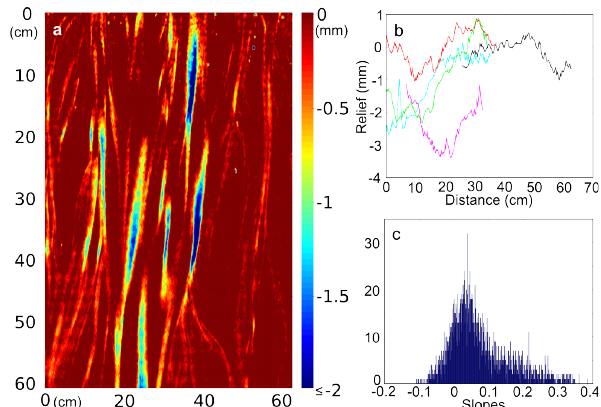
Fig. 10. (a) Planview of the analyzed section of the braided river system. Colors correspond to water depth values. The direction of water flow is from the top to the bottom of the image; channel- ized threads are visible as vertical lines. (b) Within-channel ele- vation profiles of the five longest continuous channel threads. Pro- files are plotted from an x-value corresponding to the distance down Sect. (a) at which the channel begins. (c) Histogram of cross-stream slope values within the channels, at the channel banks (outer 3mm). Channel boundaries are defined using the wet fraction 3rd -quartile threshold discussed in the text.